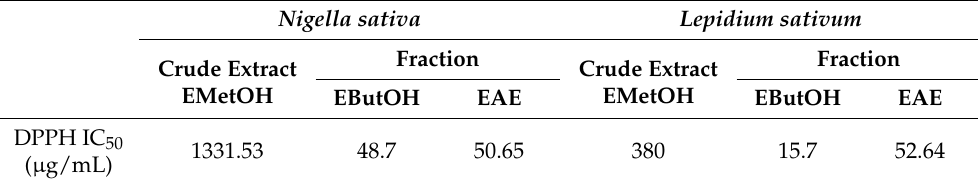
Table 3. The IC50% of different extracts of N. sativa and L. sativum .